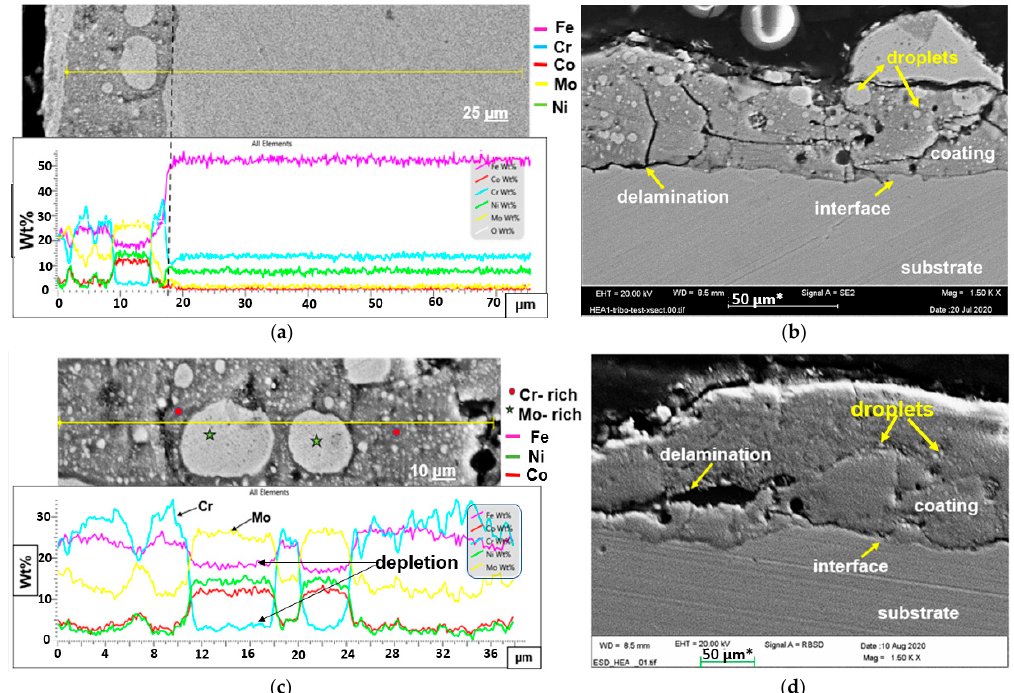
Figure 4. SEM and BSE micrographs of the cross-section and EDX line scans, revealing of the as-sprayed ( a , b ) ESD-HEA_Mo 27 and ( c , d ) ESD-HEA_Mo 20 coatings. Cross-section micrographs in Figure 4 show the microstructure of the ESD HEACs. The two-phase microstructure was characterized by a single-phase dark grey matrix and a significant amount of spherical droplet particles, as shown in Figure 4. The dark grey matrix was highly oxygenated with no secondary phases present. A pulsed-arc welding process is used to build multi-pass ESD HEA layers on the substrate from individual splats of the material from the electrode. A single spot deposit using this technique has a typical ‘splash appearance’ [38]; therefore, droplet particles were likely trapped if uneven heating and electric field oscillations occurs during the manual application. The obvious difference between the coatings HEA_Mo 20 compared to HEA_Mo 27 (SEM micrographs of Figure 4d over Figure 4b) is the increased thickness and consolidated microstructure with- out the large globules indicating spraying of fine molten droplets along the discharge arc during argon shielding deposition. A homogeneously dense and adherent two-phase mi- crostructure with no pores was reported by Karlsdottir et al. [39] for the same deposition technique as for the HEA_Mo 20 (QS + Mo) coating. However, the HEA electrode was pre- pared by vacuum arc melting with multiple passes (3–4) in that study and thus thicker and more uniform coating was obtained. The ESD process produced a coating thickness of 23.5 ± 5 µm and 28.8 ± 6 µm for HEA_Mo 27 and HEA_Mo 20 , respectively, which the approximated value is comparable to already reported single deposit thickness [38]. The droplet particles appear light grey in SEM/EDX analysis and are rich in Mo, although traces of Cr and O are also found. The maps and line profiles from Figure 4a,c confirmed a considerable amount of Cr, Fe and Mo in the HEACs. The Fe and Cr content increased from substrate melting and mixing in the liquid pool, which explained the craters’ high Fe content from the surface analysis (see Figure 3). The ESD process has been reported to promote Cr segregation in FeCrMo type alloys with CrxOy formation [39]. There is also evidence of this in this work, as clearly shown in the composition profile scans in Figure 4a,c, showing depletion of Fe and Cr indicated by lower wt% in the un-melted regions. The entrapped powder particles contributed to coating layer-to-layer (L/L) fusion and de- fects in substrate-coating interfacial (S/C). As seen in Figure 4b, spherical voids in the coat- ing could also be generated by entrapped gas during deposition. Furthermore, branched cracks originated from the bridging of the voids during so- lidification. Residual thermal effects and stresses most likely propagated other cracks, ei- ther parallel or perpendicular to the surface. The L/L stresses created within the coating during L/L fusion promoted the formation of cracks, which propagated vertically (see Fig- ure 4b). Additionally, delamination cracks also formed in a direction parallel to the surface (see Figure 4b,d). Hence, delamination resulted in a weak metallurgical interlayer at the S/C interface.